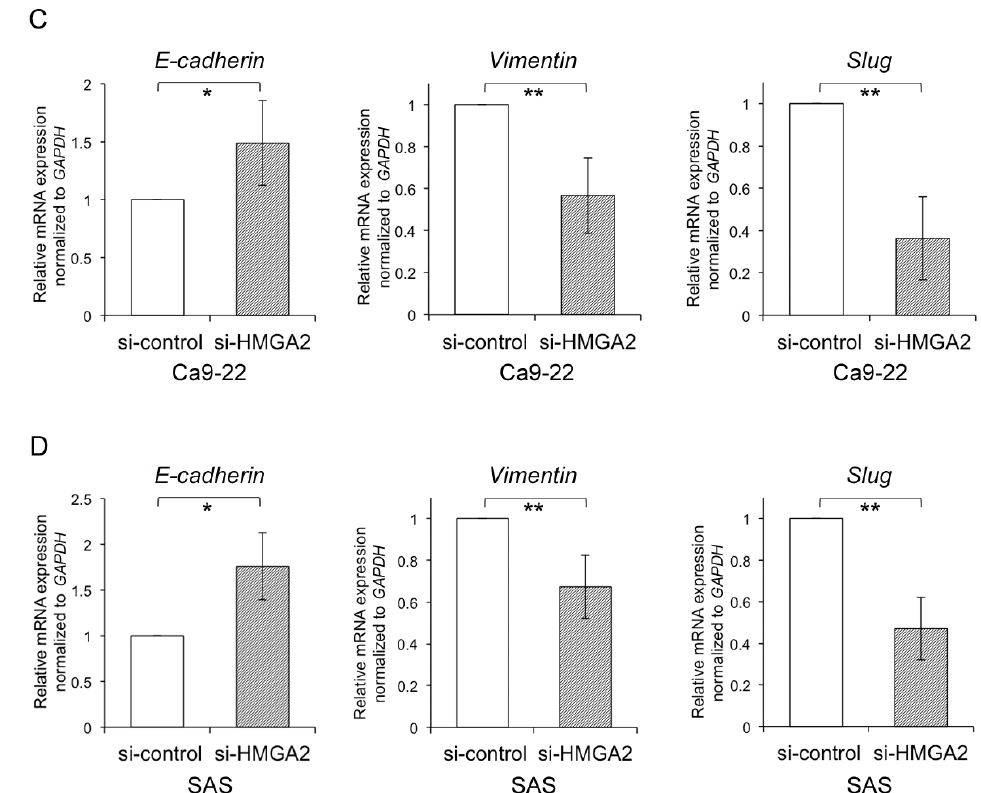
Figure 2. HMGA2 controls the expression of epithelial–mesenchymal transition (EMT) markers in oral squamous cell carcinoma (OSCC) cell lines. ( A , B ) The mRNA and protein expression levels of HMGA2 in Ca9-22 cells and SAS cells transfected with HMGA2 siRNA or control. Total RNA and whole-cell lysates were used for qRT-PCR ( A ) and western blot analysis ( B ), respectively. ( C , D ) The mRNA expression levels of E-cadherin , Vimentin , and Slug were measured using qRT-PCR with Ca9-22 cells ( C ) and SAS cells ( D ) transfected with si-HMGA2. The values are expressed as the means ± s.d. of triplicate samples. Statistical analysis was performed using a Student’s t -test. * p < 0.05, ** p <